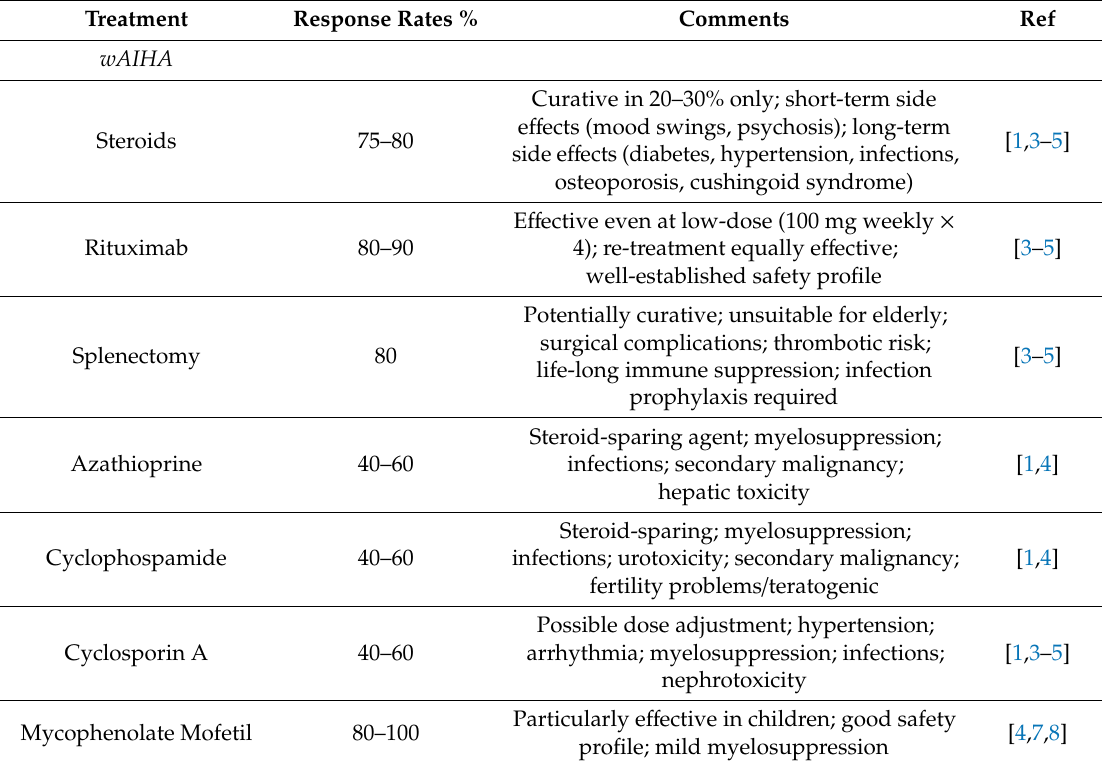
Table 3. Standard therapies for warm AIHA (wAIHA) and cold agglutinin disease (CAD).